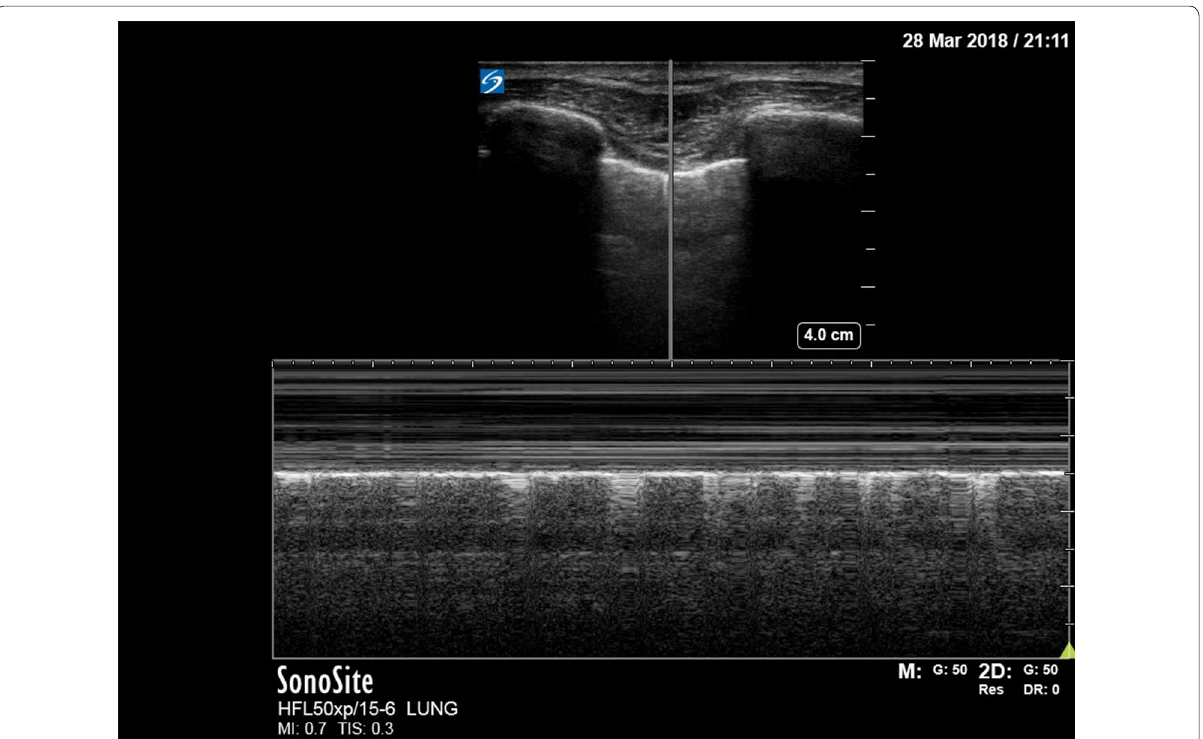
Fig. 3 Normal lung—M‑mode ultrasound image. The ultrasound reflections on the vertical line in the upper part of the image are sequentially displayed from left to right in the lower part as time progresses. It allows to capture the motion of the upper 2D image in the stationary image below. A normal M‑mode image of the chest wall and pleura is displayed here. The stationary chest wall produces straight horizontal lines above the pleural line. The lung sliding and movement of the artifacts below produces a grainy image. This is called the seashore sign